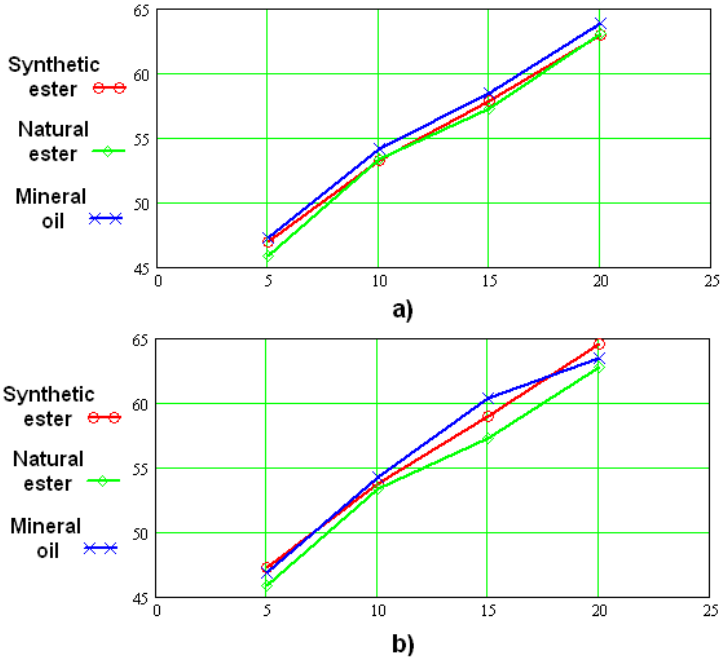
Figure 4. Inception voltage of streamers versus gap distance: ( a ) negative polarity of lightning impulse, ( b ) positive polarity of lightning impulse; x -axis represents gap distance in (mm), y -axis represents inception voltage in (kV) [81].